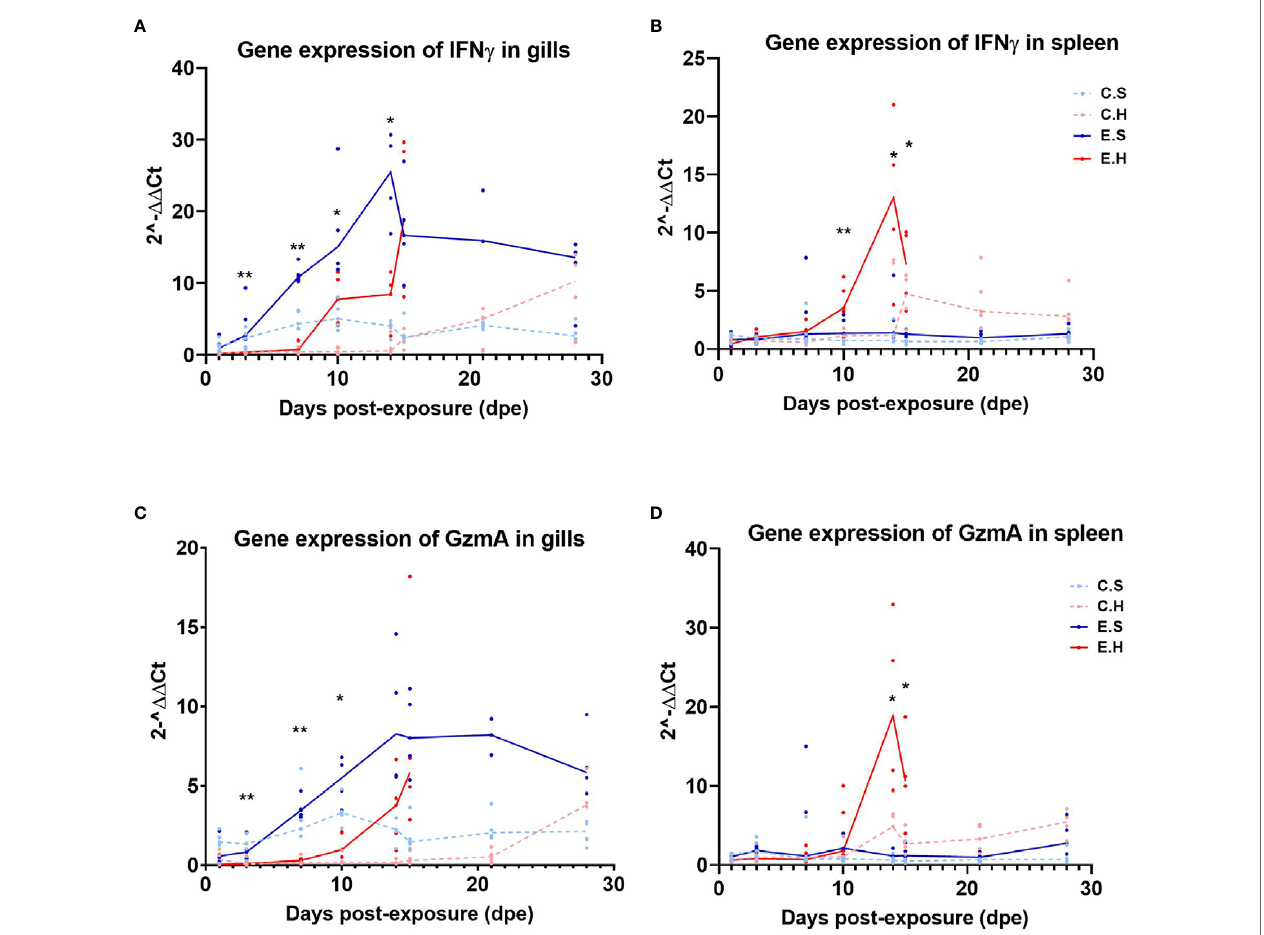
FIGURE 5 | Gene expression of IFN g in gills (A) and spleen (B) and GzmA in gills (C) and spleen (D) from the experimental trial. Each dot represents data from one individual salmon and the solid line represents the median value for each group. The signi fi cant differences for all fi gures are measured between the two infected groups. *P<0.05, **P< 0.01. C.S, Uninfected control sham injected group; C.H, Uninfected control hydrocortisone-injected group; E.S, SGPV-exposed sham injected group; E.H, SGPV-exposed hydrocortisone-injected